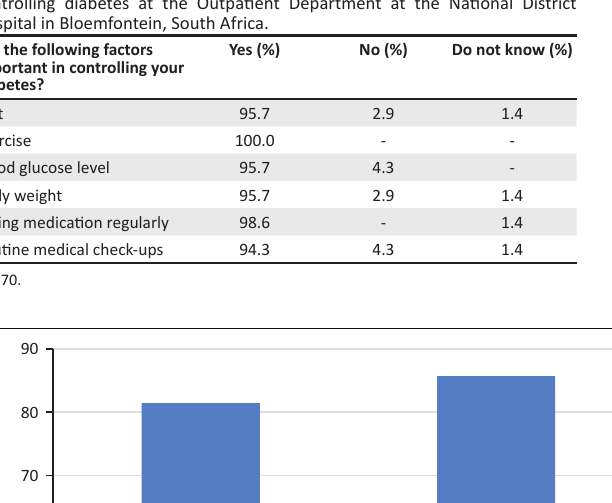
a g n t e c e r P